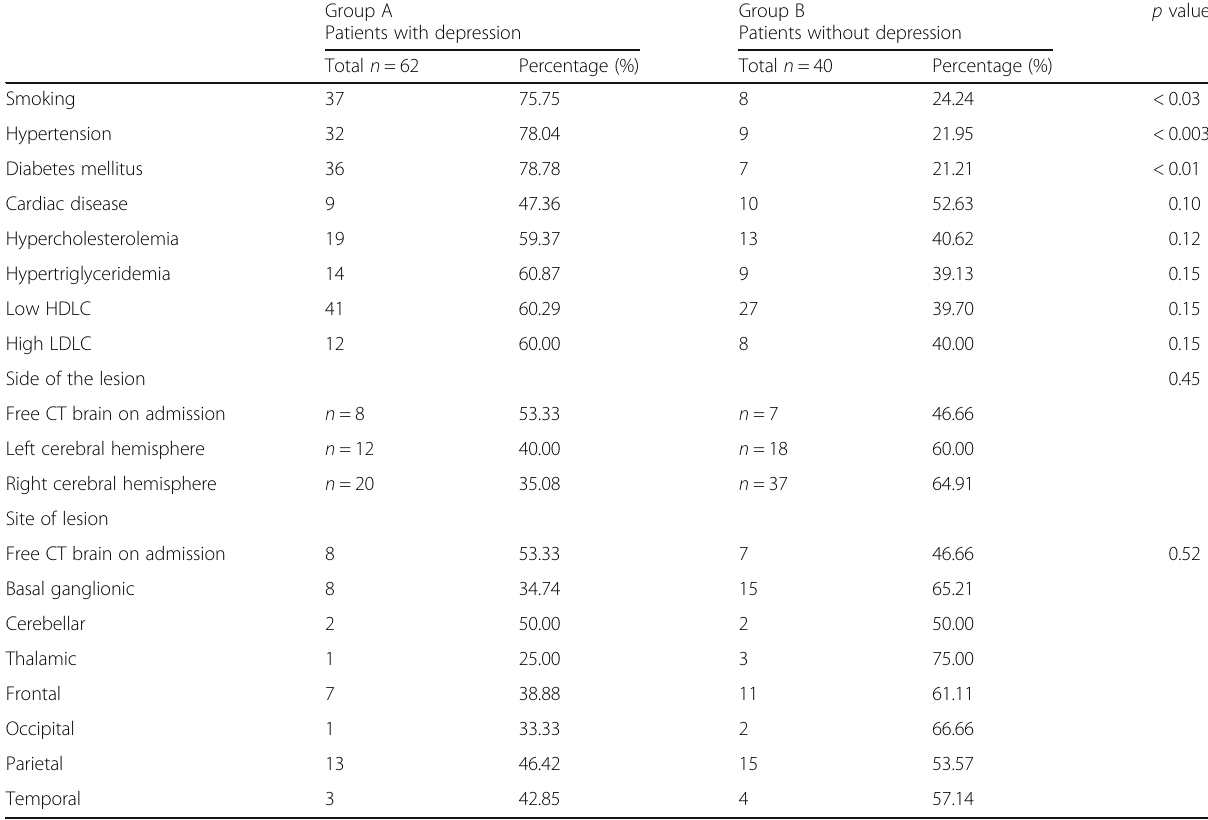
Table 2 Clinical, laboratory, and radiological data in both groups